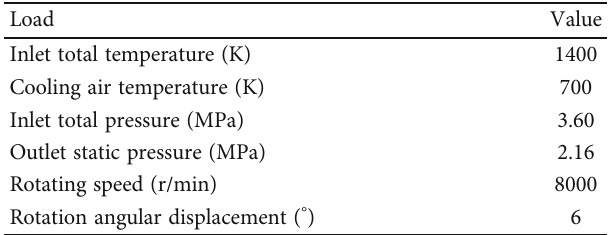
Table 3: Loads applied in the numerical simulation.